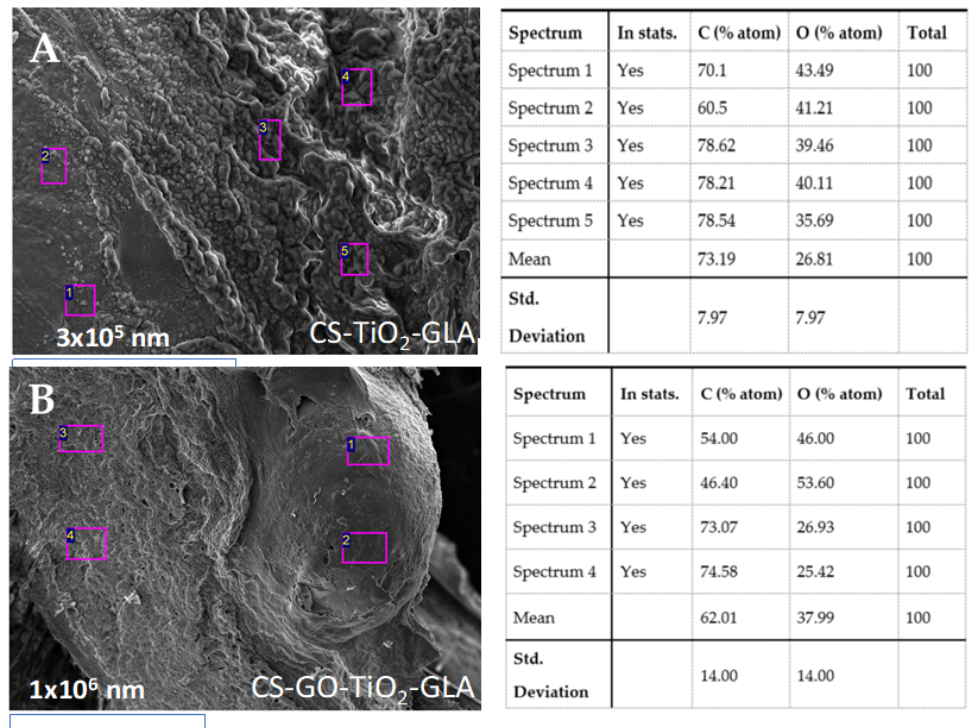
Figure 11. Beads implanted in subdermal tissue. ( A ) CS-TiO 2 -GLA. ( B ) CS-GO-TiO 2 Figure 1. Schematic representation of methotrexate (MTX)-encapsulated dendrimers for the treatment of bone metastasis which allow the suppression of tumor cells in mice.